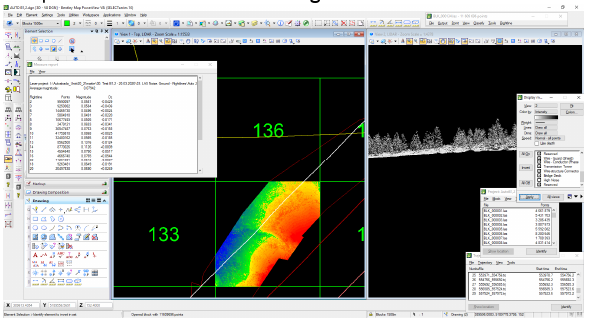
Figure 14 . Strip calibration and partial results using TerraMatch We start from an average magnitude between strips of 10 cm and in the end of adjustments we reach an average magnitude between strips of 3 cm ( Figure 15 ).